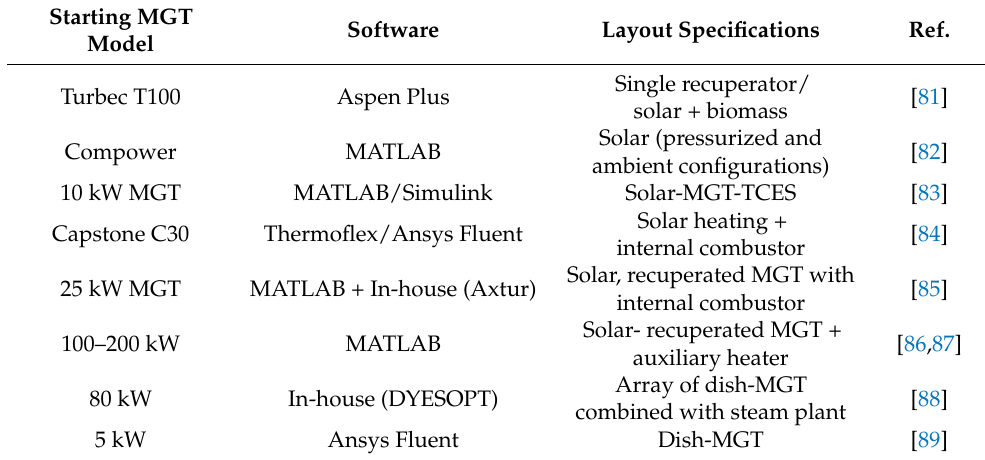
Table 6. Summary of Solar-MGT